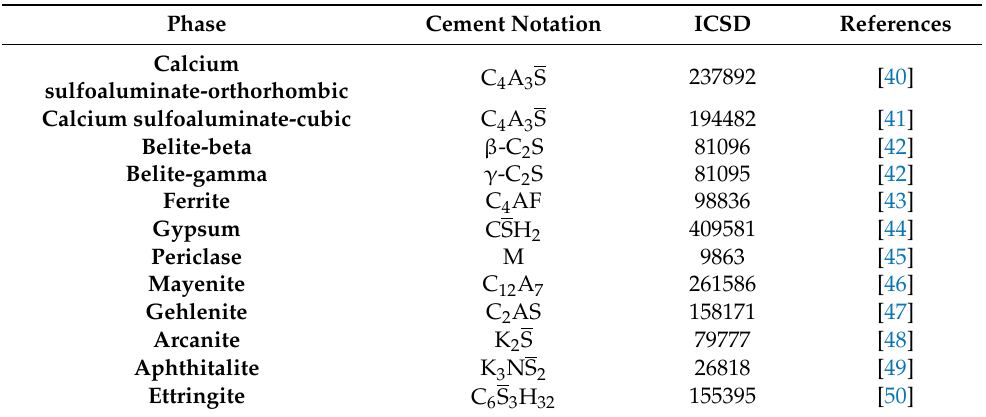
Table 3. Phase designations and ICSD entries used for the Rietveld